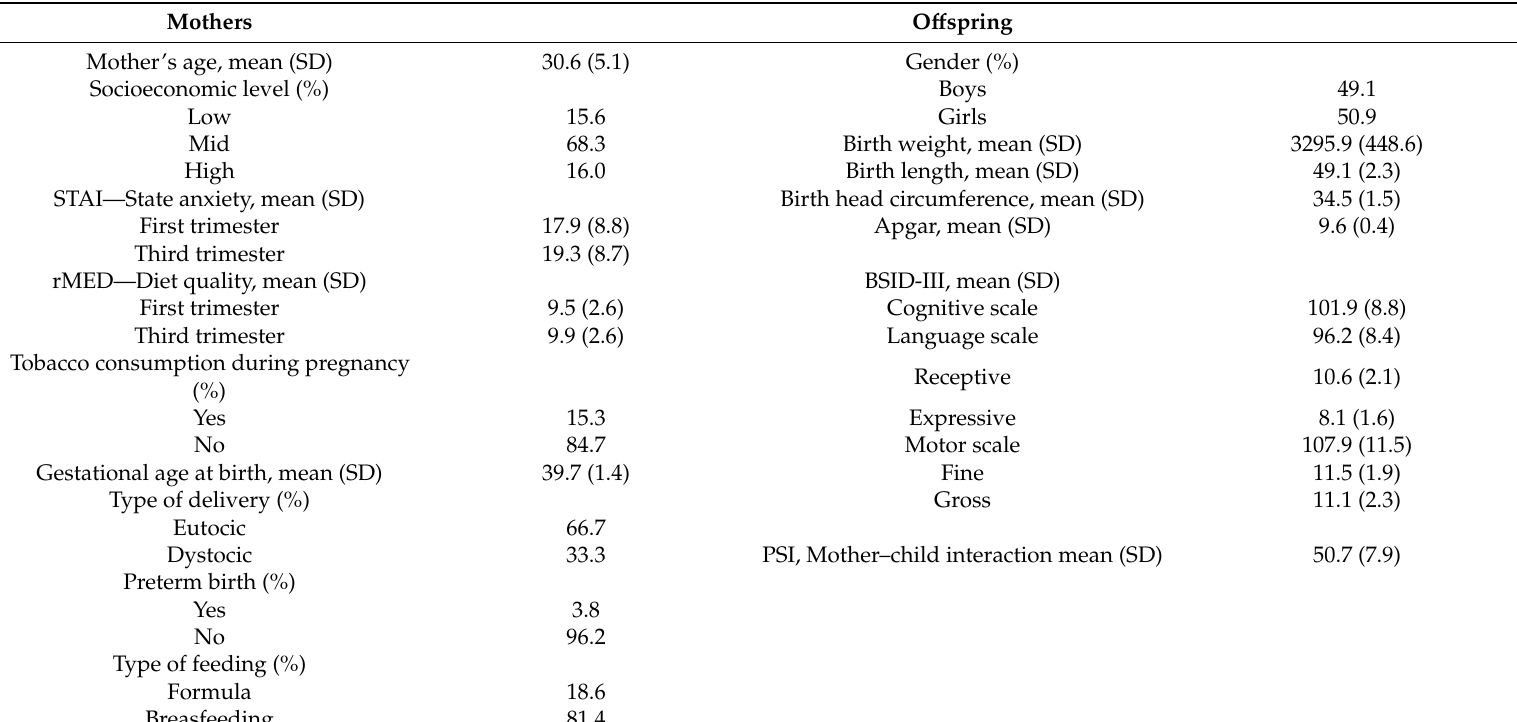
Table 2. Mother and o ff spring descriptive data: sociodemographic data, health habits, nutrition and psychological aspects.